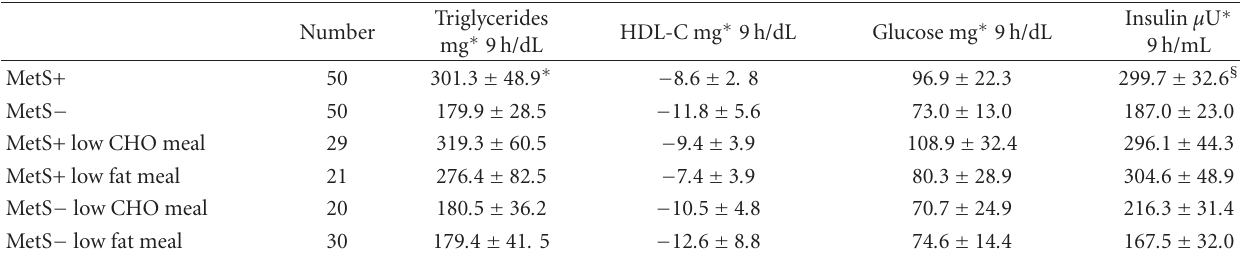
Table 2: Incremental area under the curves (IAUCs) of serum triglycerides, HDL cholesterol, blood glucose, and